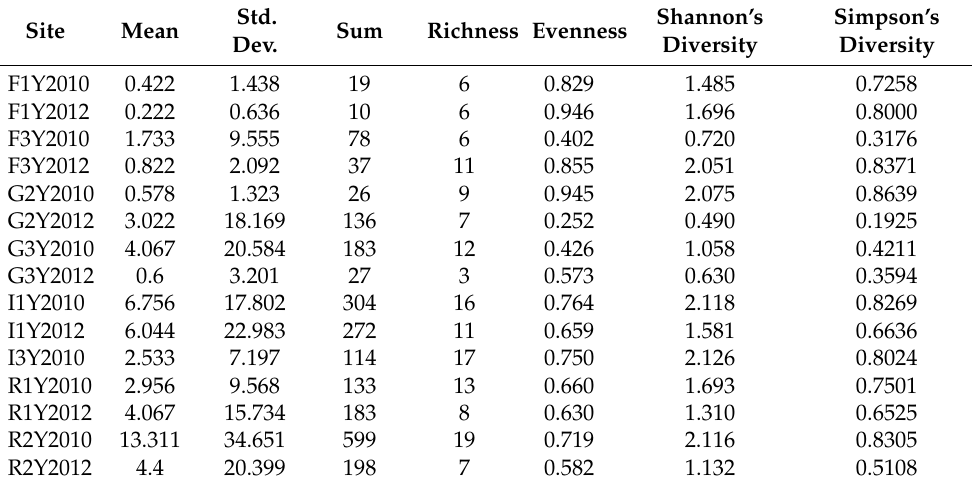
Table 2. FWI community abundance and diversity summary statistics for in the Neponset River watershed for samples collected August 2010 and August 2012 (F = Forest, G = Golf, I = Industrial, R = Residential; Y10 = 2010, Y12